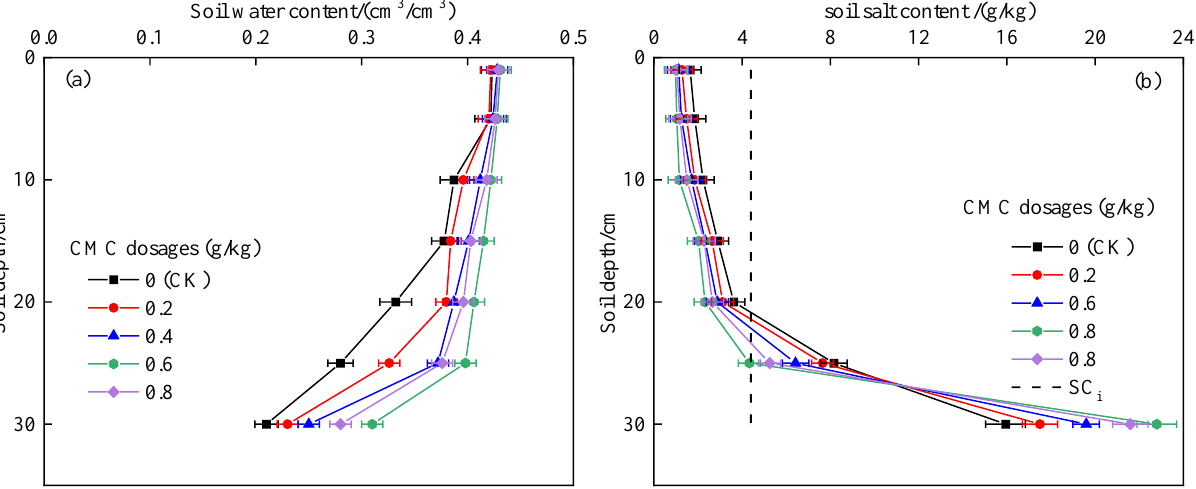
Figure 5. Effect of CMC dosage on soil water and salt content distribution. ( a ) Soil water content; ( b ) soil salt content.